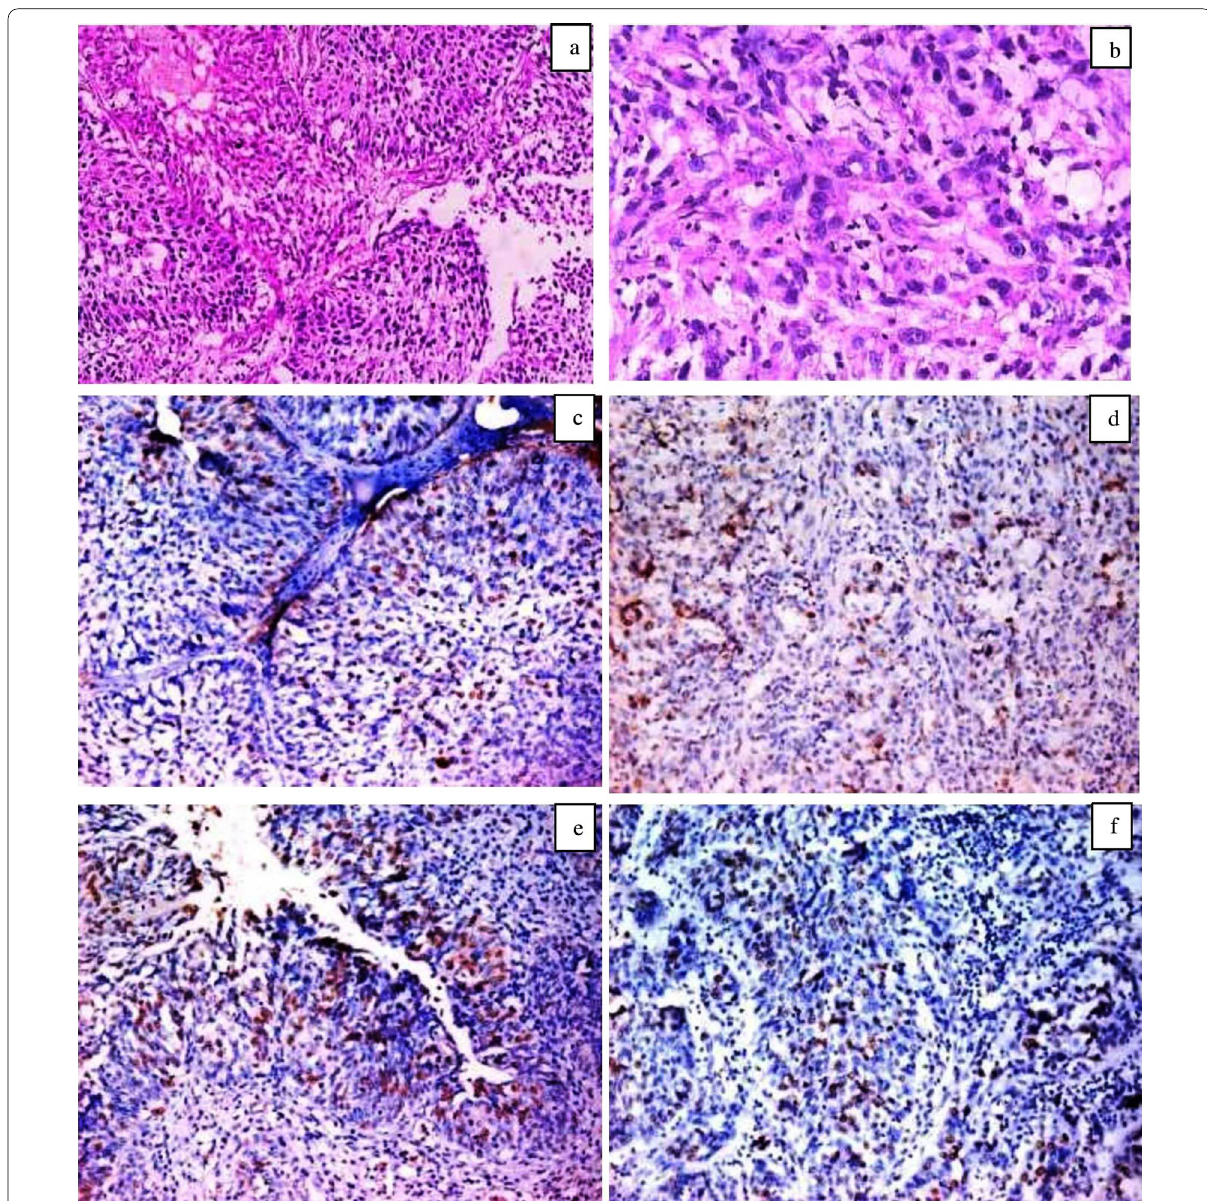
Fig. 1 Hematoxylin and eosin staining of urothelial carcinoma ( a , b ) and immunohistochemical expression of survivin ( c , d ) and P27 ( e , f ). a Low-grade papillary urothelial carcinoma ( 200), b High-grade urothelial carcinoma ( 400), c Low-grade papillary urothelial carcinoma with low × × survivin score, nuclear expression ( 200), d High-grade solid urothelial carcinoma with high survivin score, nuclear expression ( × papillary urothelial carcinoma with high P27 score, nuclear expression ( 200), f High-grade urothelial carcinoma with high P27 score, cytoplasmic × expression